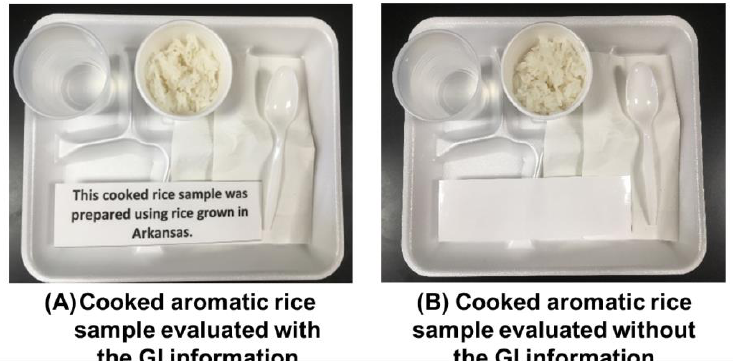
Figure 1. Examples of cooked aromatic rice samples evaluated with or without geographical indication (GI) information. ( A ) Cooked aromatic rice samples were evaluated in the presence of GI information: this cooked rice sample was prepared using rice grown in (Arkansas, Louisiana, or Thailand). ( B ) Cooked aromatic rice samples were also evaluated in the absence of GI information; a blank rectangular card containing no information was presented.